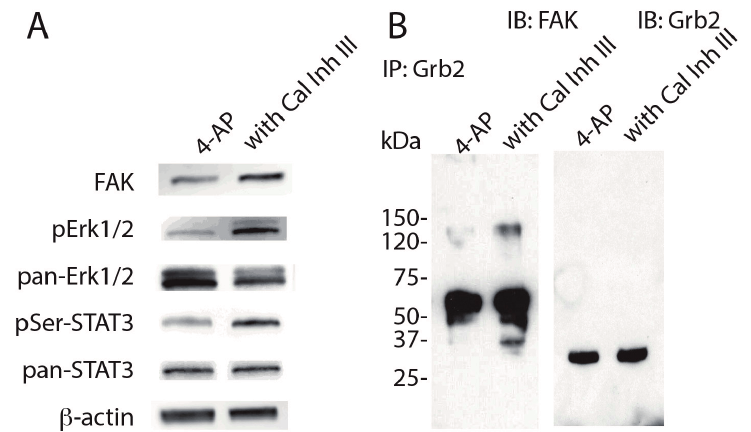
Figure 4. Inhibition of calpain blocks the effect of chronic activation on FAK levels. ( A ) Western blot analysis. β -Actin was used as control; and ( B ) Immuno-precipitation analysis. Samples were immuno-precipitated with anti-Grb2 antibody. Neurons were incubated with 5 mM 4-AP with or without 10 μ M Cal Inh